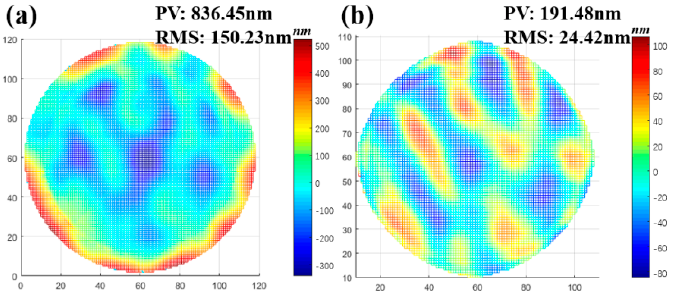
Figure 3. ( a ) Residuals after IBF simulation. ( b ) Residuals after PIB simulation.